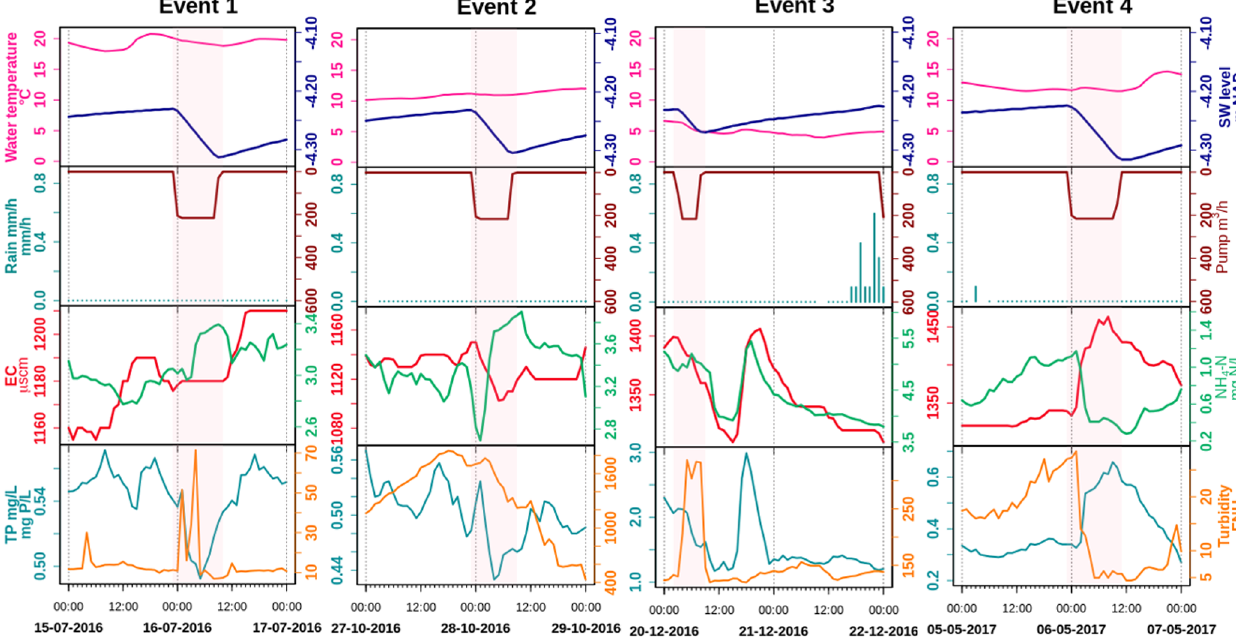
Figure 5. Pumping and pumping effect patterns on water quality; pink blocks represent the pumping duration. See Tables S11–S14 for the correlation tests performed on the